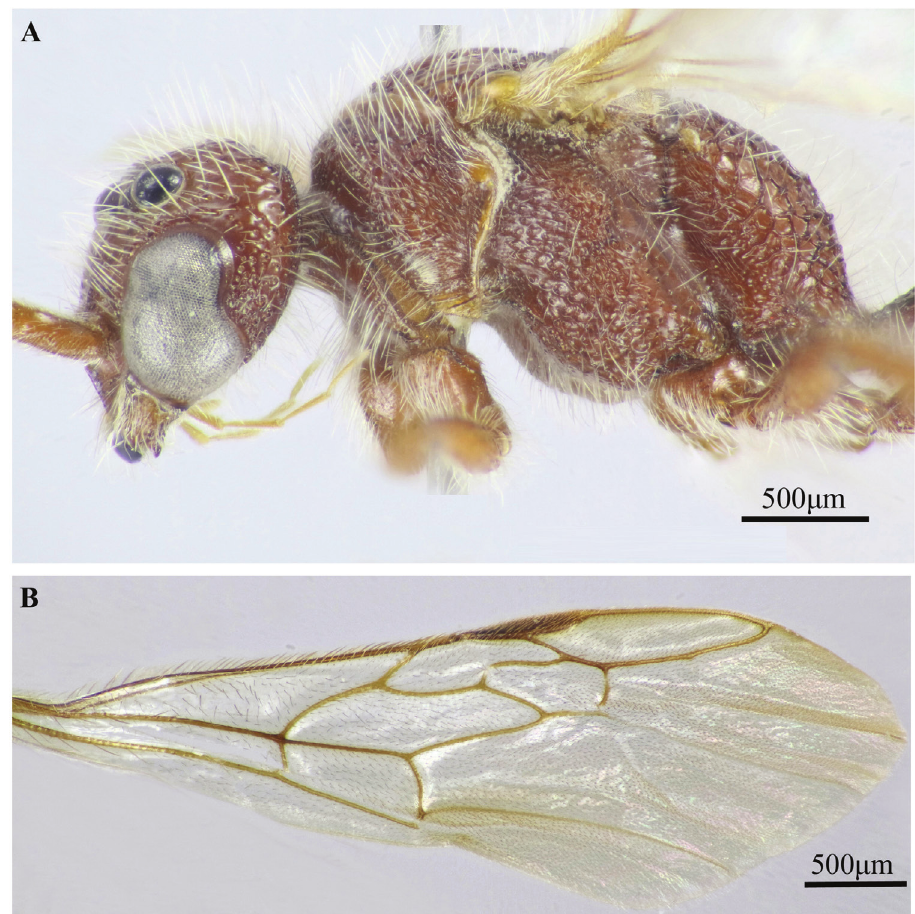
Figure 13. Pseudophotopsis dhofarensis sp. nov. (Male) A head and mesosoma, lateral view B right fore wing.